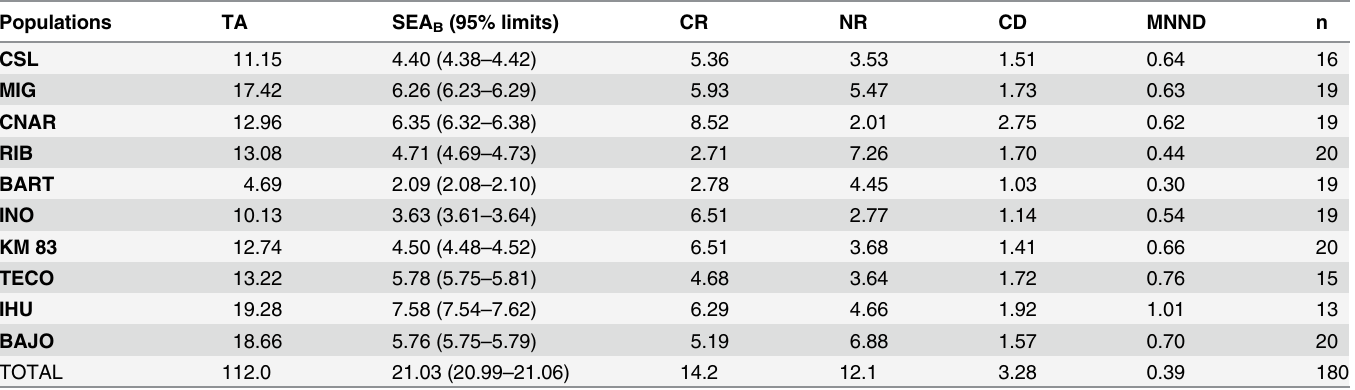
TA = Total area of convex hull; SEA B = Bayesian standard ellipse area; CR = δ 13 C range; NR = δ 15 N range; CR = Mean distance to centroid; MNND = Mean nearest neighbour distance; n = bivariate sample